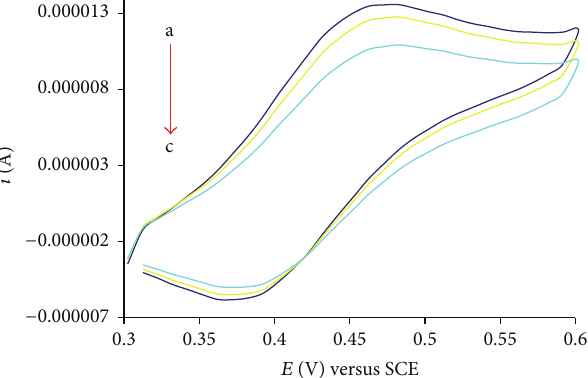
Figure 2: Cyclic voltammograms of 1mM compound 1 recorded at 100 mV/s potential sweep rate on glassy carbon electrode at 25 ∘ C in the absence (a) and presence of 1mL of 20 𝜇 M, 40 𝜇 M with increasing concentration of CT-DNA (b-c) in 20% aqueous DMSO buffer at pH 7.0; supporting electrolyte 0.1 M